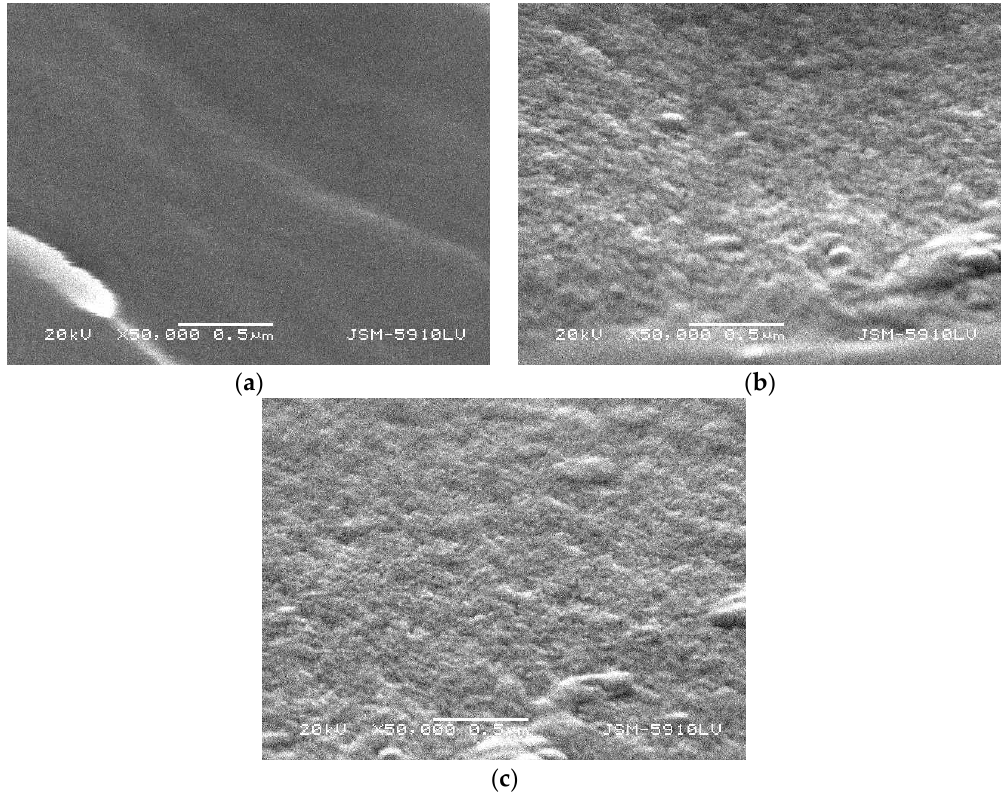
Figure 8. SEM images of the fracture surface of ( a ) S ‐ 0, ( b ) S ‐ 7.5, and ( c ) S ‐ 20 samples.